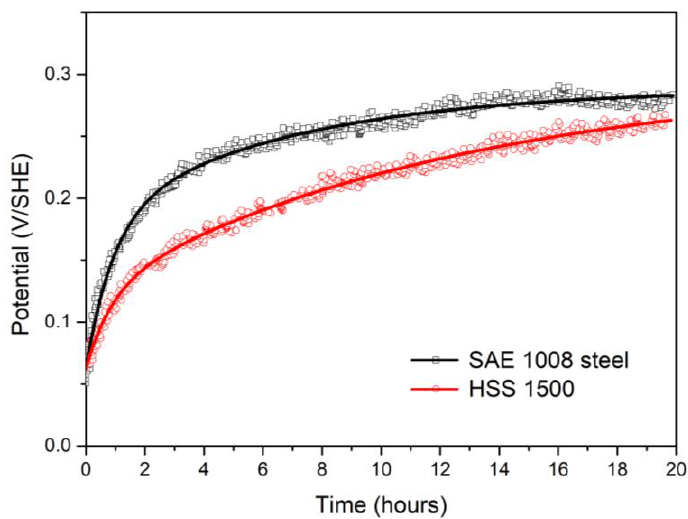
Figure 1. Monitoring of the potential of the steels in air at 60% RH and 22 °C after grinding. The SKP assessment of mild steel SAE 1008 and HSS 1500 was carried out after grind- ing and followed cathodic hydrogen charging in a 0.1 M NaOH aqueous electrolyte. Ca- face rinsing in de-ionized water and quick drying in a stream of dry air. SKP potential